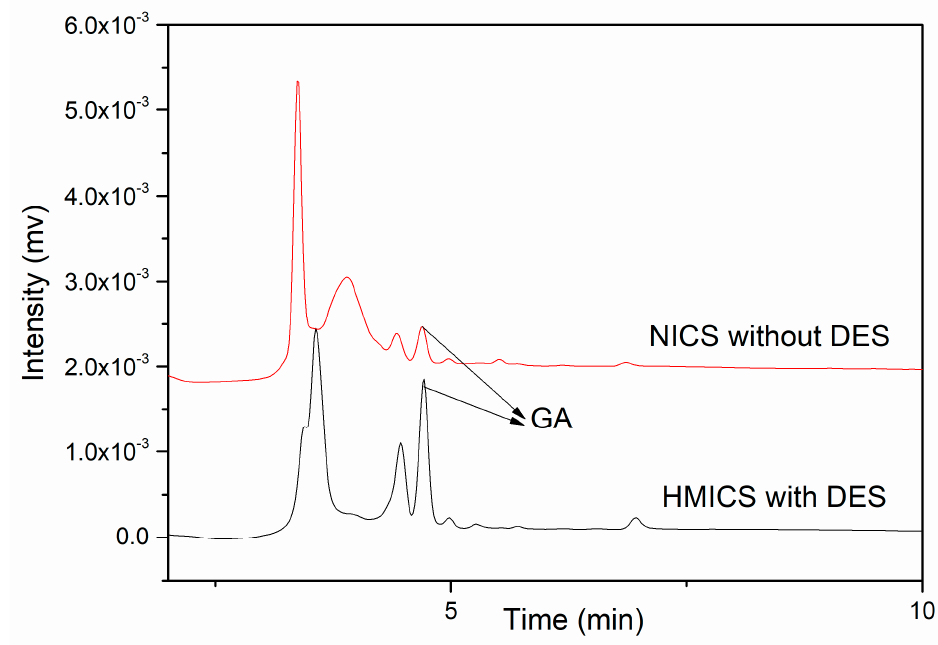
Figure 9. Extraction chromatograms of red ginseng tea extracts with HMICS with DES, and INCS without DES. (Column: C 18 column, mobile phase: (Acetonitrile-0.05% phosphoric acid solution = 5:95, v / v ), flow rate: 1.0 mL · min − 1 , UV: 270 nm, injection: 20 µ Table 1. Intra-day and Inter-day precisions and accuracy of GA.